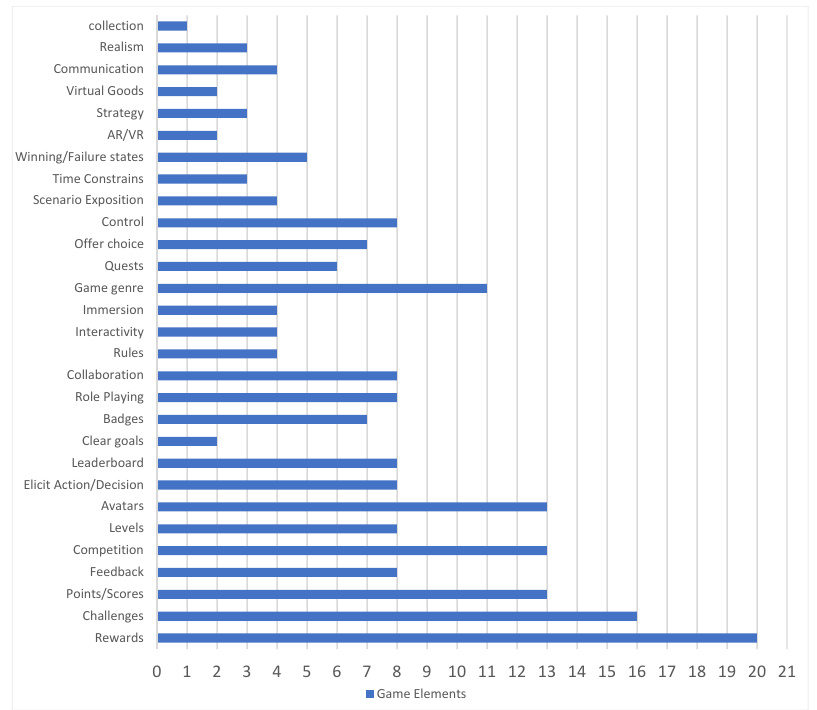
Figure 7. Frequency of game features in the Psychology domain.